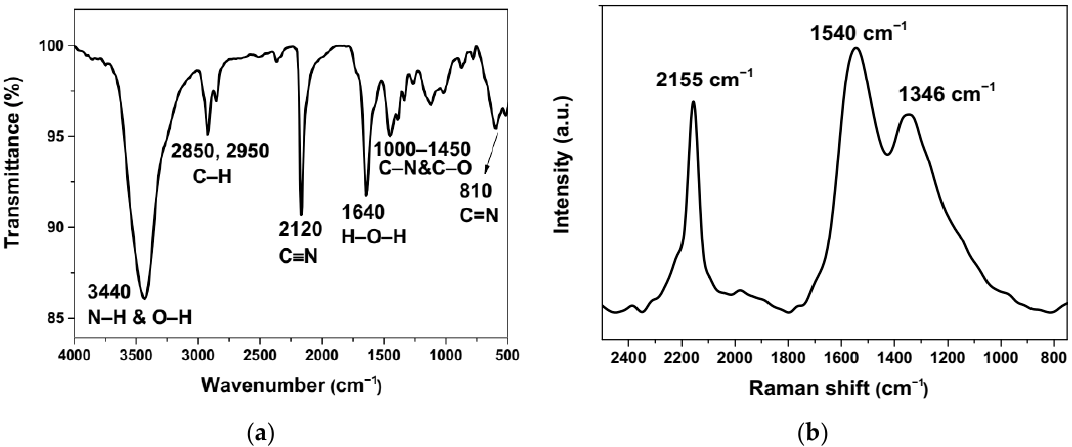
Figure 5. ( a ) FTIR and ( b ) Raman spectra of Cu / gCN hybrid material synthesized using pulsed laser ablation in acetonitrile.